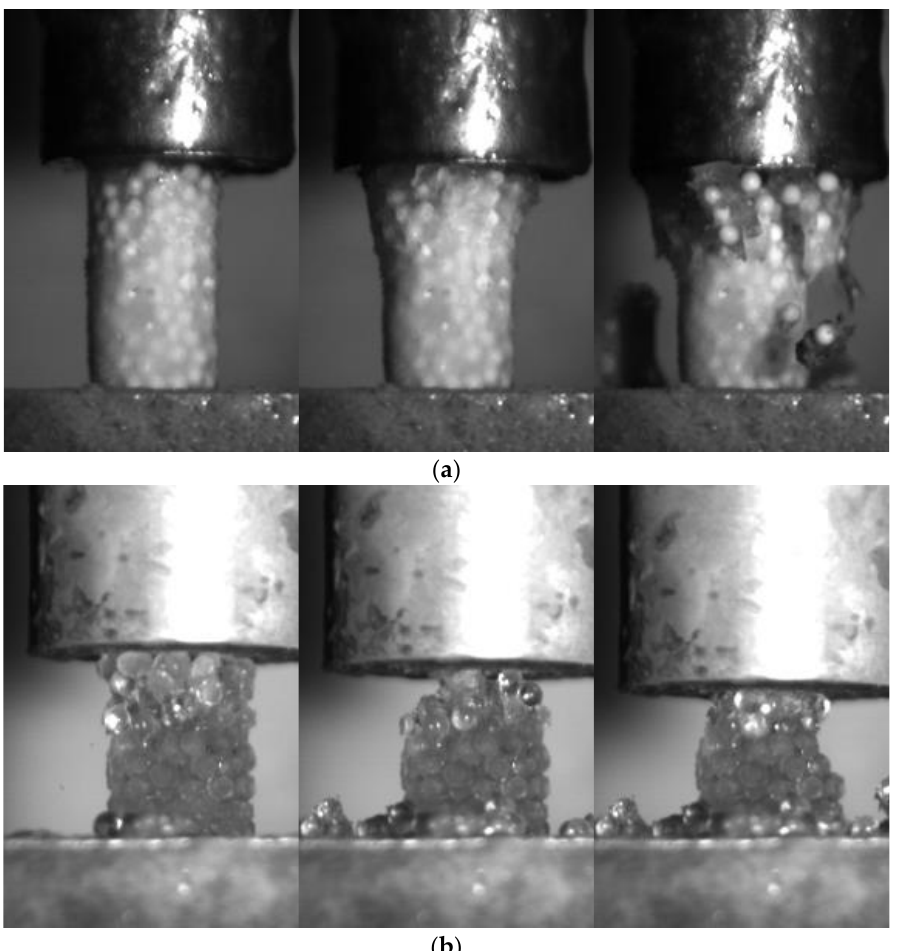
Figure 5. The fracture pattern for agglomerates at the strain rate is 10 −2 s −1 : ( a ) 100% saturation, alpha-alumina PFS (Supplementary material: Video S1); ( b ) 75% saturation, glass PFS (Supplementary material: Video